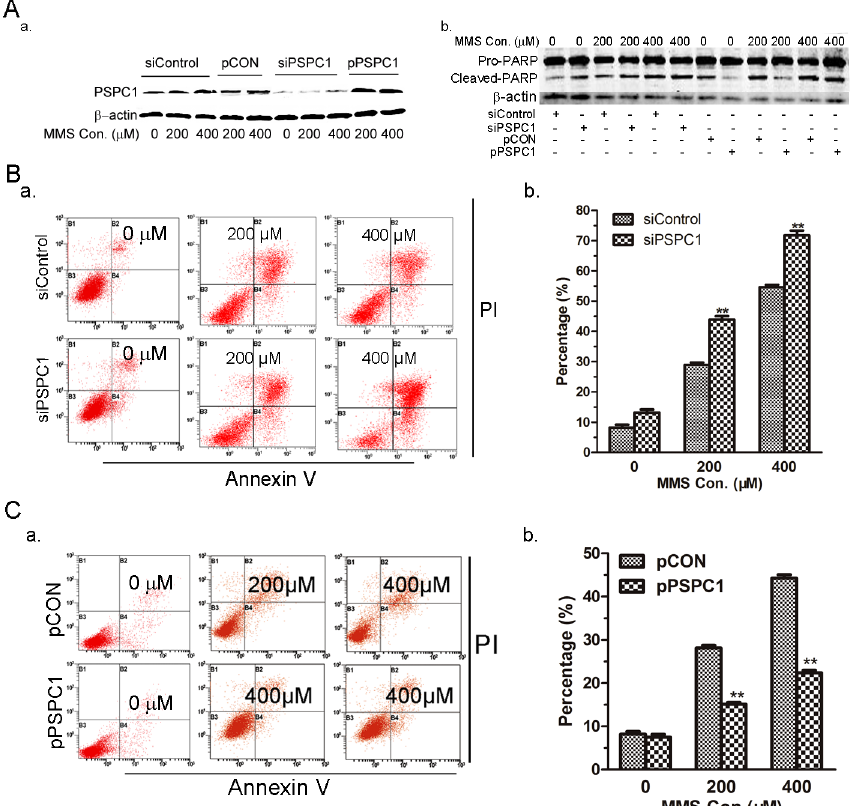
Fig 4. Effect of PSPC1 on MMS-induced apoptosis. (A) HeLa cells were transfected with siPSPC1, siControl, pPSPC1, or pControl for 24 h, followed by 200 or 400 μ M of MMS treatment for 12 h prior to analysis of PSPC1 and PARP expression by Western blot. For the detection of apoptosis, HeLa cells transfected with siRNAs (B) or overexpression plasmids (C) were treated with 200 or 400 μ M of MMS for 12 h, and then analyzed by dual-parameter flow cytometry utilizing Annexin V-FITC and PI double staining. Representative dot plot data from three independent experiments are shown in the left panel, and the histogram graph in the right panel represents the percentage of dual-parameter positive cells pooled from three independent experiments. Data are presented as the mean ± SD of three independent experiments. ** p < 0.01, as compared with the control